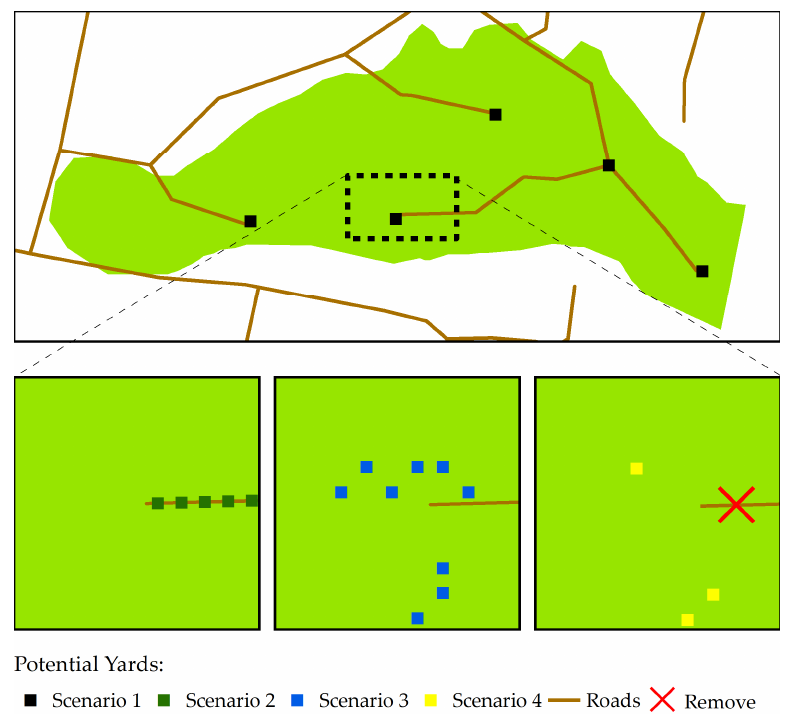
Figure 2. Graphical representation of considered planning scenarios. Table 2. Setting up the network optimization in the Network Analyst